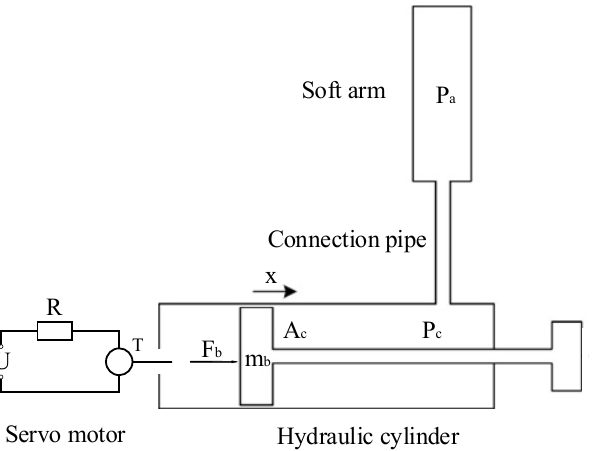
Figure 4. Schematic diagram of the hydraulic system for driving the soft manipulator. At the left is the schematic representation of the servo motor, and at the right is the representation of the piston and hydraulic cylinder. Above is a schematic representation of the soft manipulator and connecting pipes.